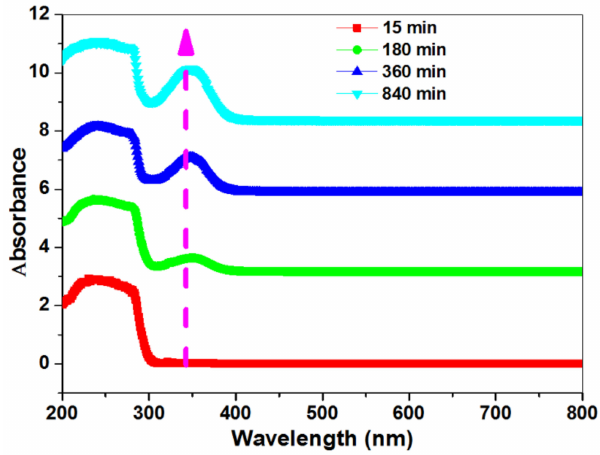
Figure 13. UV-vis. Spectroscopy for the formation of grafted poly (NIPAAm- Co -DEAMVA)- g - tryptophan as a function of absorbance with